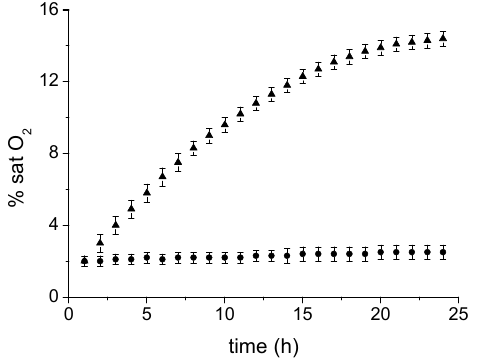
Figure 6. Plot of the percentage of O 2 dissolved in solution vs time for complexes 1 ( (cid:78) ) and 2 ( ).